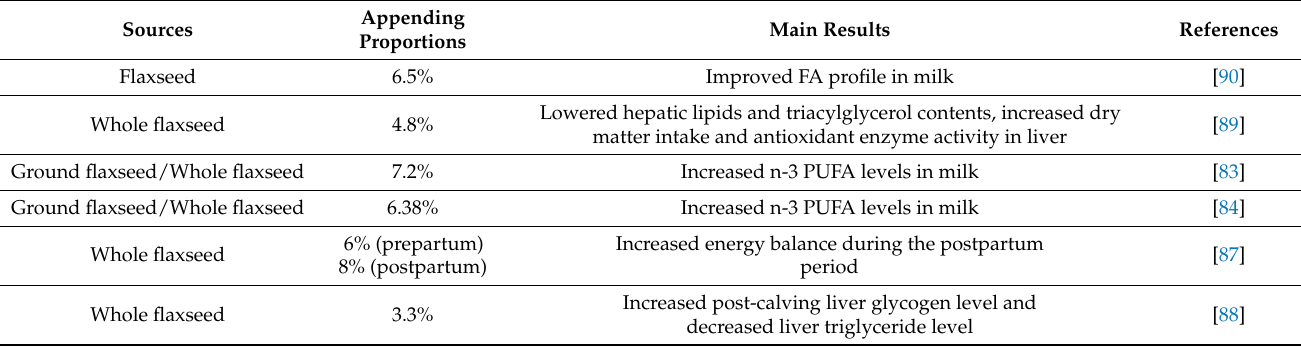
Table 7. Application of flaxseed and flaxseed meal in the dairy cow.